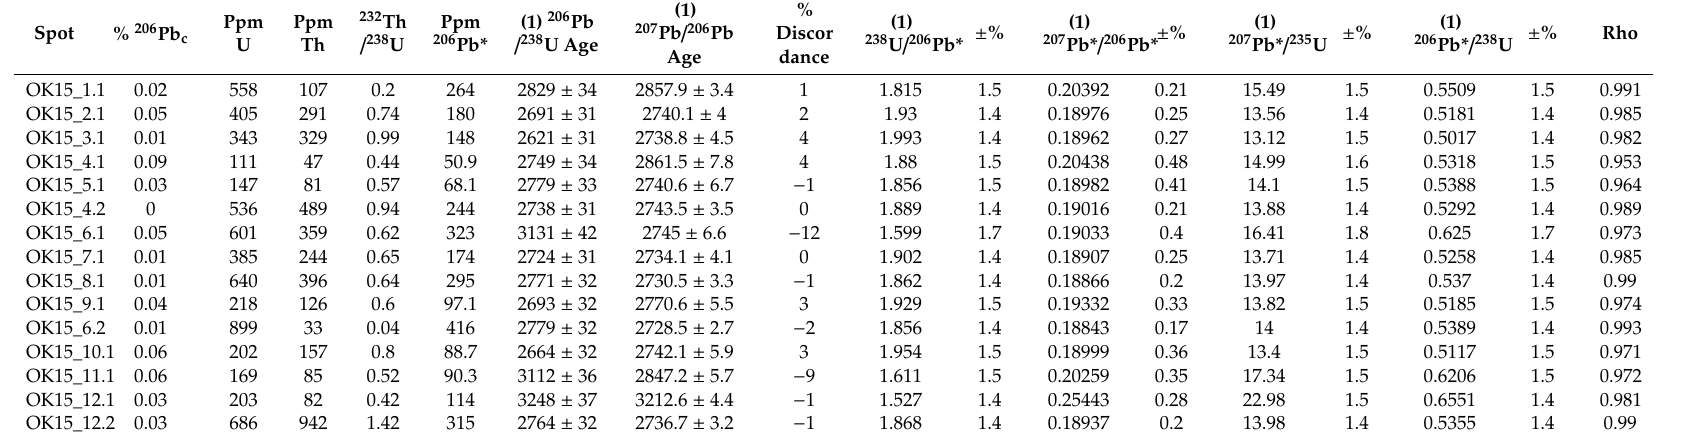
Table 6. Isotopic U–Pb data for zircons from OK-15 sample (diorite-gneiss from the DW